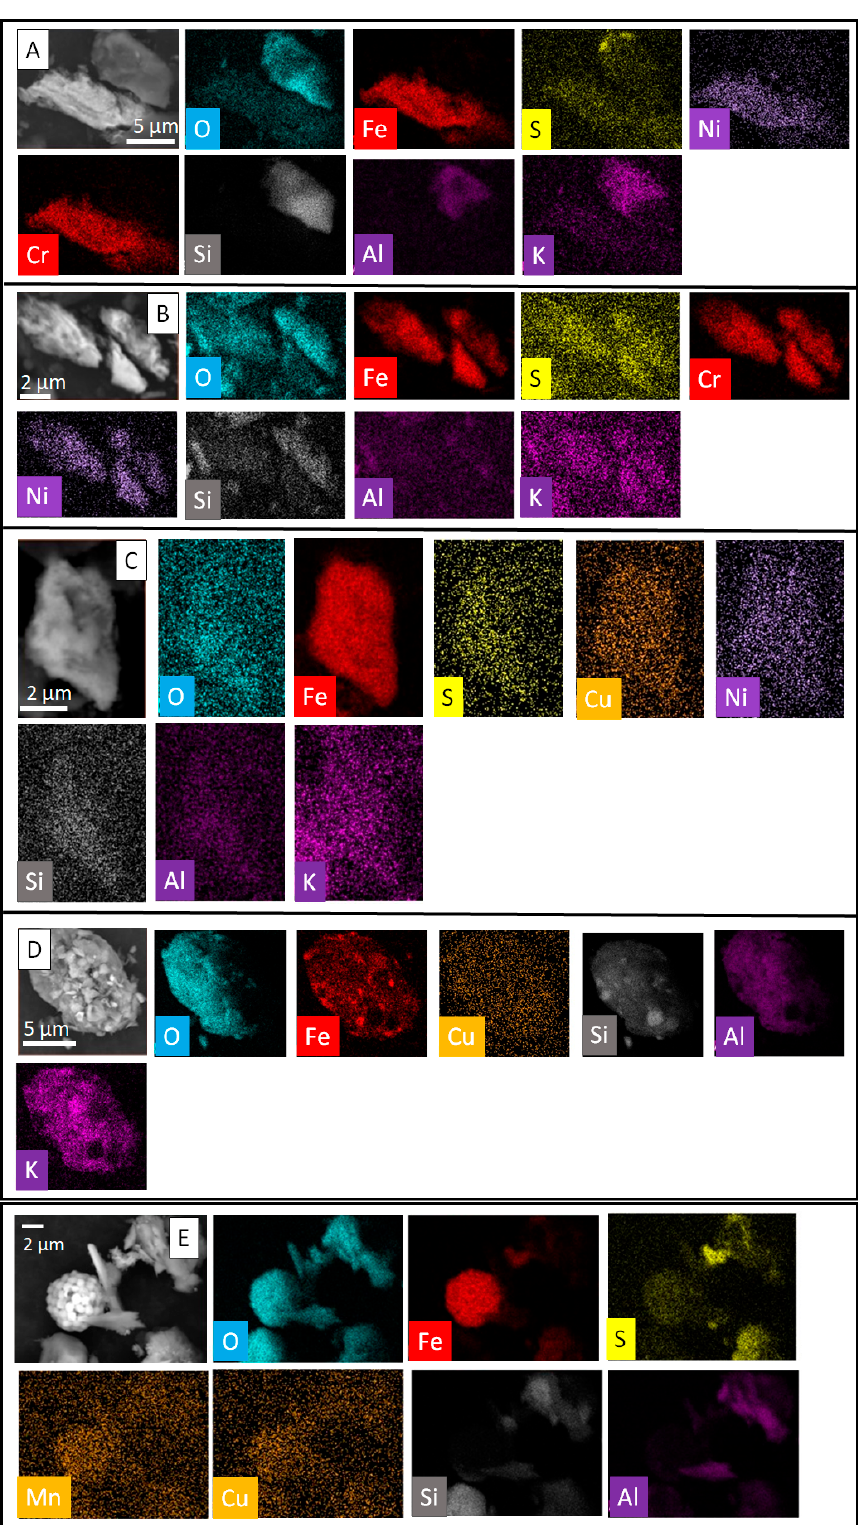
Figure 3. ( A – D ) Representative Fe(III) ‐ (oxy)hydroxide and ( E ) pyritic colloids collected from bulk soils developing on historic coal mine spoil and collected from spoil piles 1 ( A , B ), 2 ( E ), 3 ( C ), and 9 ( D ).